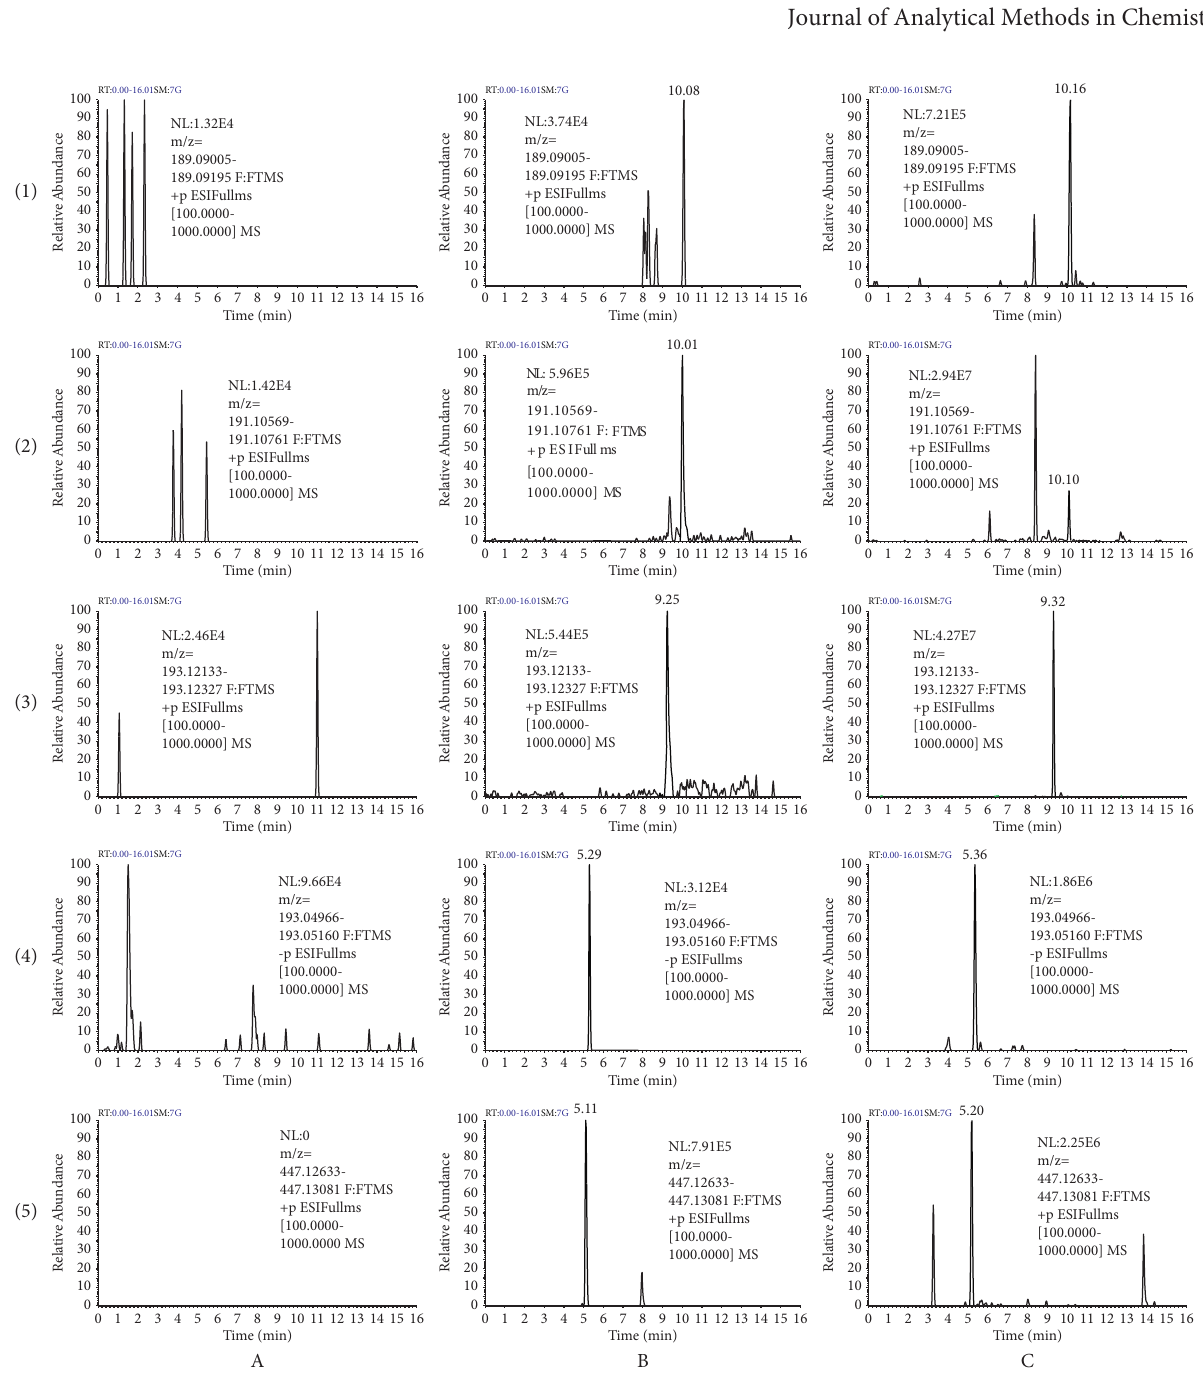
Figure 3: Representative chromatograms of butylidenephthalide (1), ligustilide (2), senkyunolide A (3), ferulic acid (4), and calycosin-7-O- β -D-glucoside (IS) (5) in rat plasmas: (a) blank plasma samples; (b) blank plasma samples spiked with butylidenephthalide, ligustilide, senkyunolide A, and ferulic acid at LLOQ and IS; and (c) plasma samples obtained at 1h after oral administration of RCR at a dose of 24.01 g/kg. Table 1: Calibration curves and linearity for butylidenephthalide, ligustilide, senkyunolide A, and ferulic acid in rat plasma. Analytes Standard curve Correlation coefficient ( R 2 ) Linear range (ng/mL) Butylidenephthalide y � 0.1818 x +0.0025 0.9991 2.38–950.00 Ligustilide y � 1.6324 x +0.1124 Senkyunolide